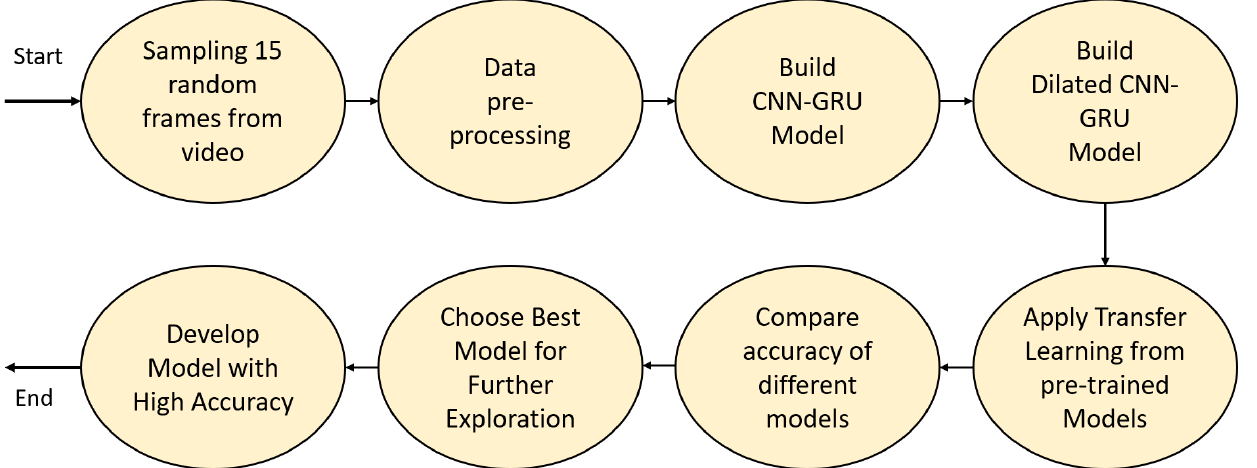
Figure 1. Overview of constructing the cricket batting-shot categorization model. CNN—convolutional neural network; GRU—gated recurrent